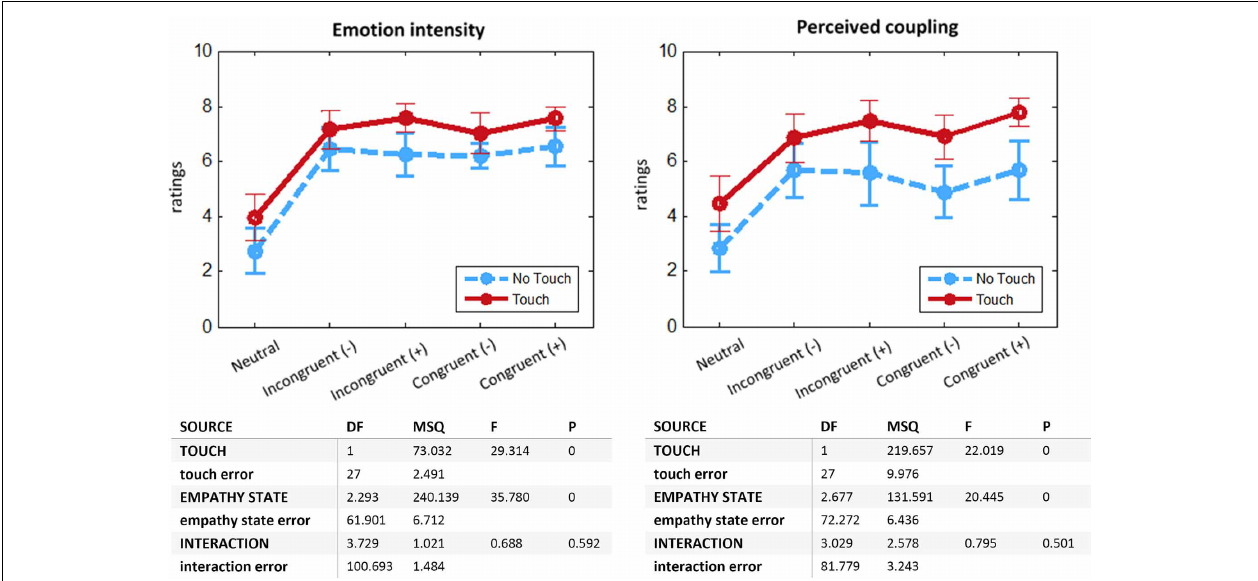
FIGURE 2 | Onlineself-reportratings:meanswith95%CIsandANOVAtables.Left: Emotionintensityfeltduringpreviousrun. Right: Perceivedcouplingwith romantic partner during previous run. Two-Way ANOVA with repeated measures, departure from sphericity corrected with Greenhouse-Geisser method. N = 28.